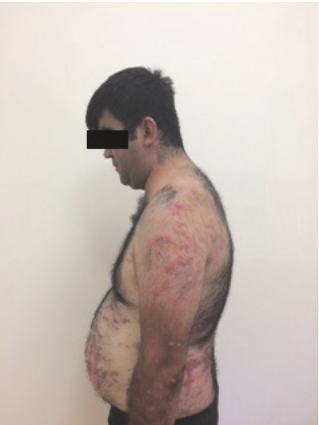
Figure 1: He had a moon face appearance with truncal obesity, buffalohump,hypertrichosisintrunk,andpurplestriaeintheaxilla, periumbilical, and inguinal region.